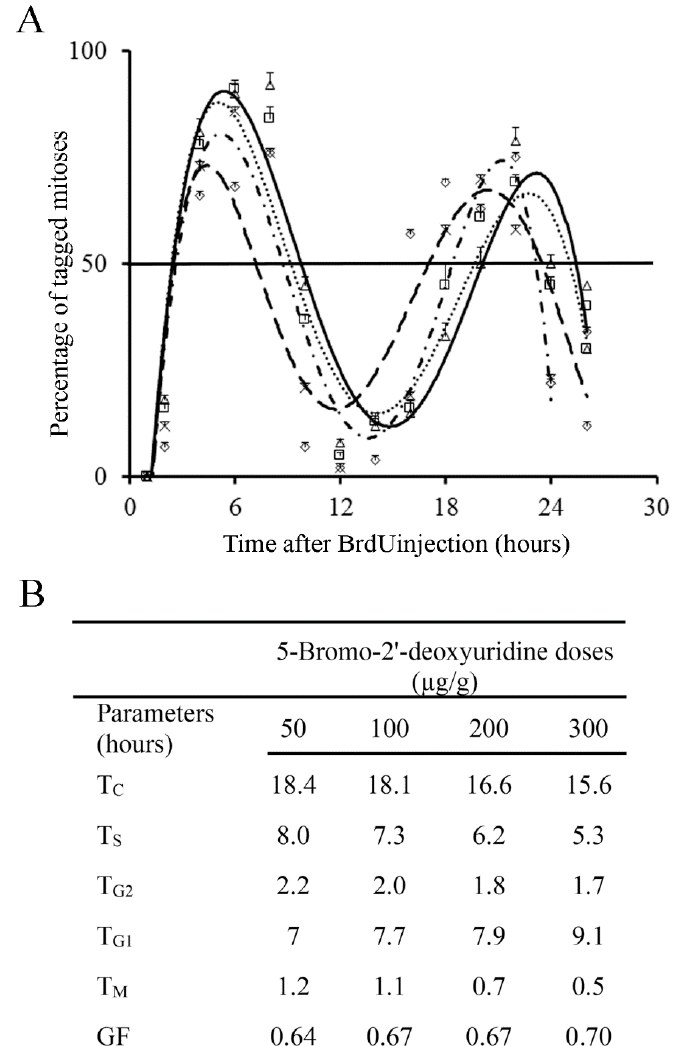
Figure 5. ( A ) Frequency of labeled mitoses in the external granular layer at successive times follow- ing a single injection of 50 µg/g (open triangles and solid black lines), 100 µg/g (open squares and dotted line), 200 µg/g (crosses and short broken lines), and 300 µg/g of BrdU (diamonds and large broken lines). Data are expressed as mean ± SEM. ( B ) Values for phase durations and cell-cycle length of the EGL cells. T C : duration of the whole cell cycle. T S : duration of the S-phase. T G2 : duration of the G2 phase. T G1 : duration of the G1 phase. T M : duration of the mitotic phase. GF: growth fraction.